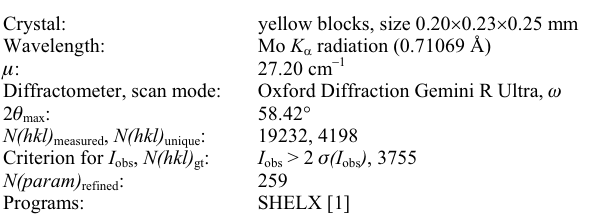
Table 1. Data collection and handling.